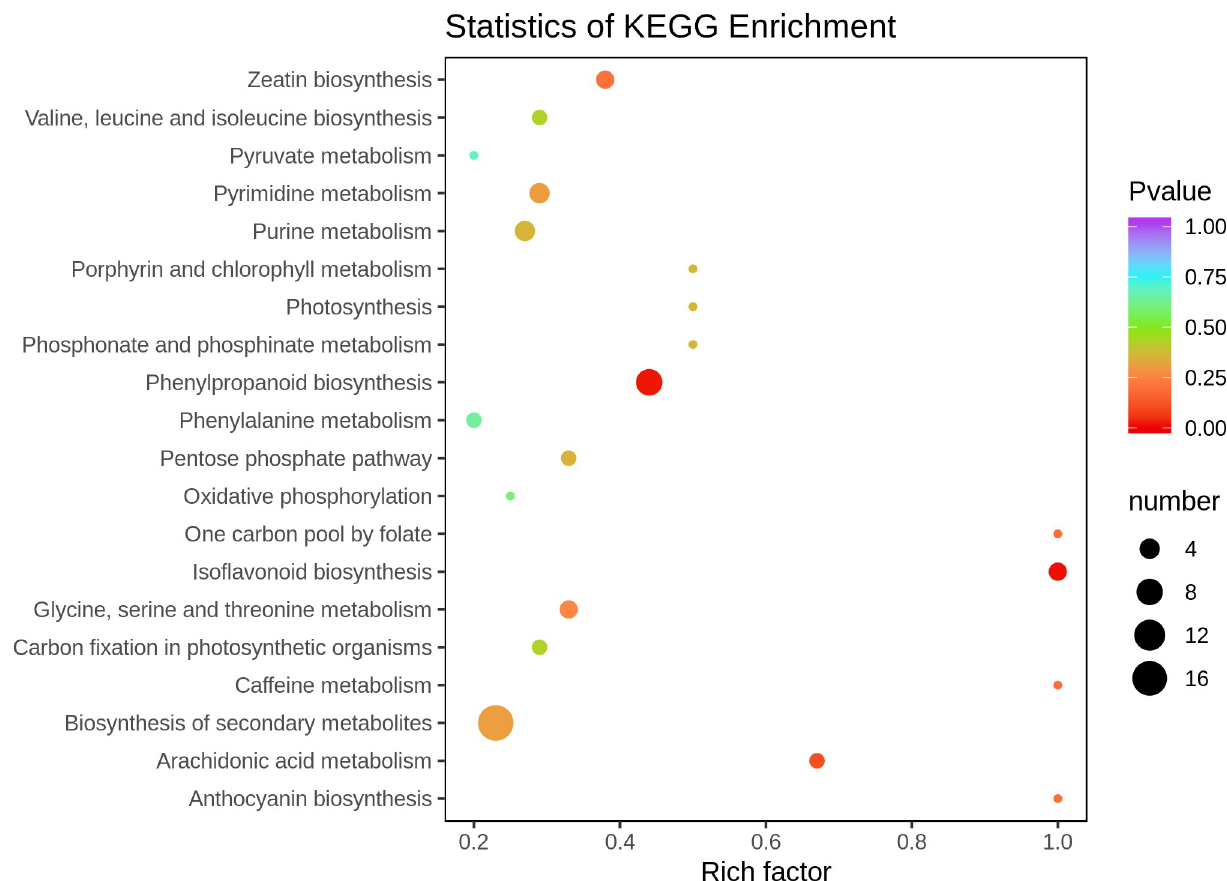
Fig 4. Data for enrichment of significantly different metabolites (only the top 20 pathways are